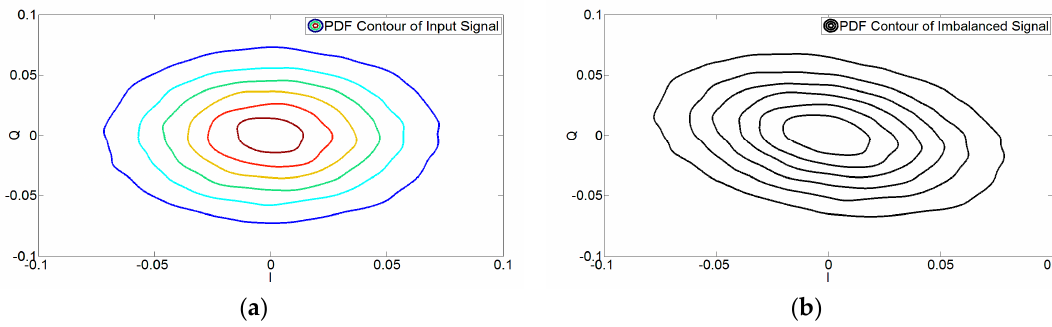
Figure 2. Contour plot for the PDF of Wideband Code Division Multiple Access (WCDMA) 1111 ( a ) input and ( b ) imbalanced output I / Q signals using the Kernel Density Estimation (KDE) method. A deviation from the input signal’s PDF can be seen due to I / Q imbalance.